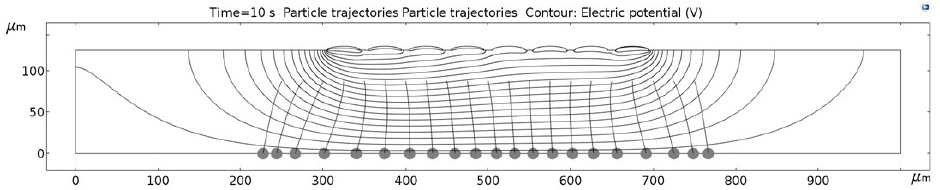
Figure 17. Computed particle trajectories and electric potential for the Parabolic notch electrode geometry.